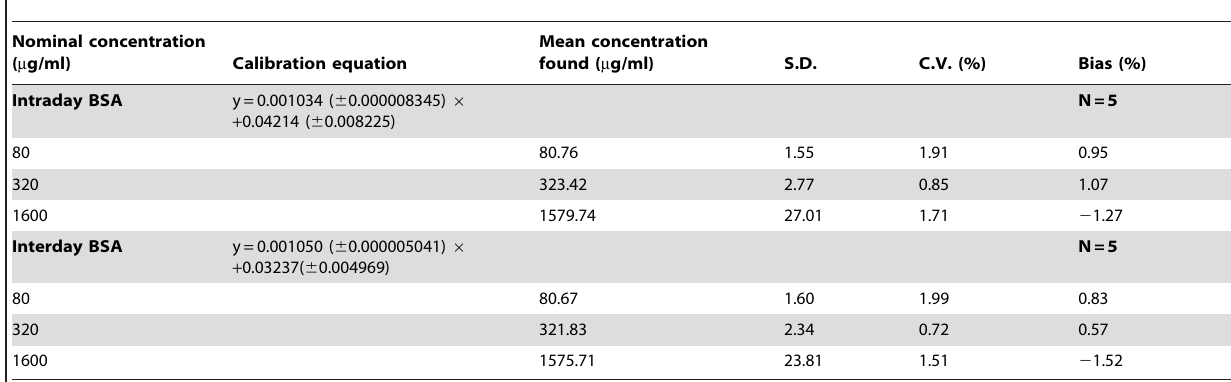
Table 3. Validation of the bicinchoninic acid (BCA) method for quantification of BSA solution (means 6 S.D., N=5).